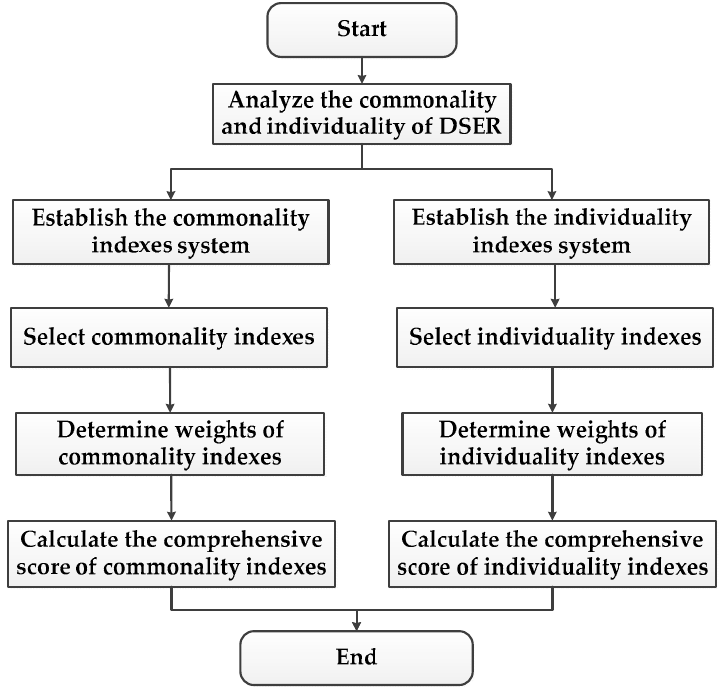
Figure 1. Flow chart for calculating the composite score. The Establishment of Commonality Indexes System for demand-side energy resources (DSER).